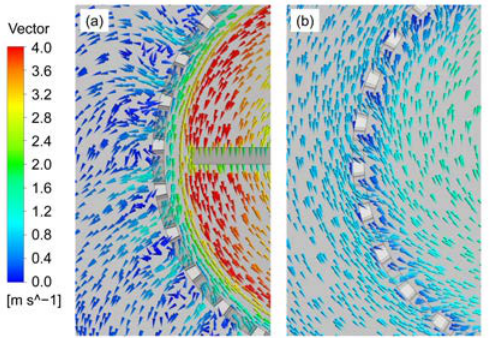
Figure 6. Velocity vectors near the stator sidewall holes for the two types of rotor-stator agitators at the horizontal plane of Z = 0.105 m under the stirring speed of 400 rpm; ( a ) CSRS agitator; ( b ) HCSRS agitator.